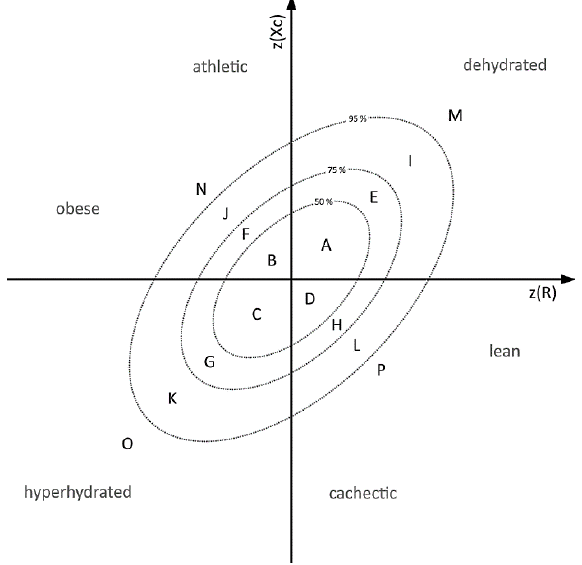
Figure 1. Subdivision Model of Z-Scores based on 50%, 75% and 95% tolerance ellipses A: Annotation of the 50%, 75% and 95% tolerance ellipses based on Norman et al. [21]. Sectors M and I (dehydrated), K and O (hydrated), and A, B, C, D (control) were defined to classify the patients according to the hydration status.